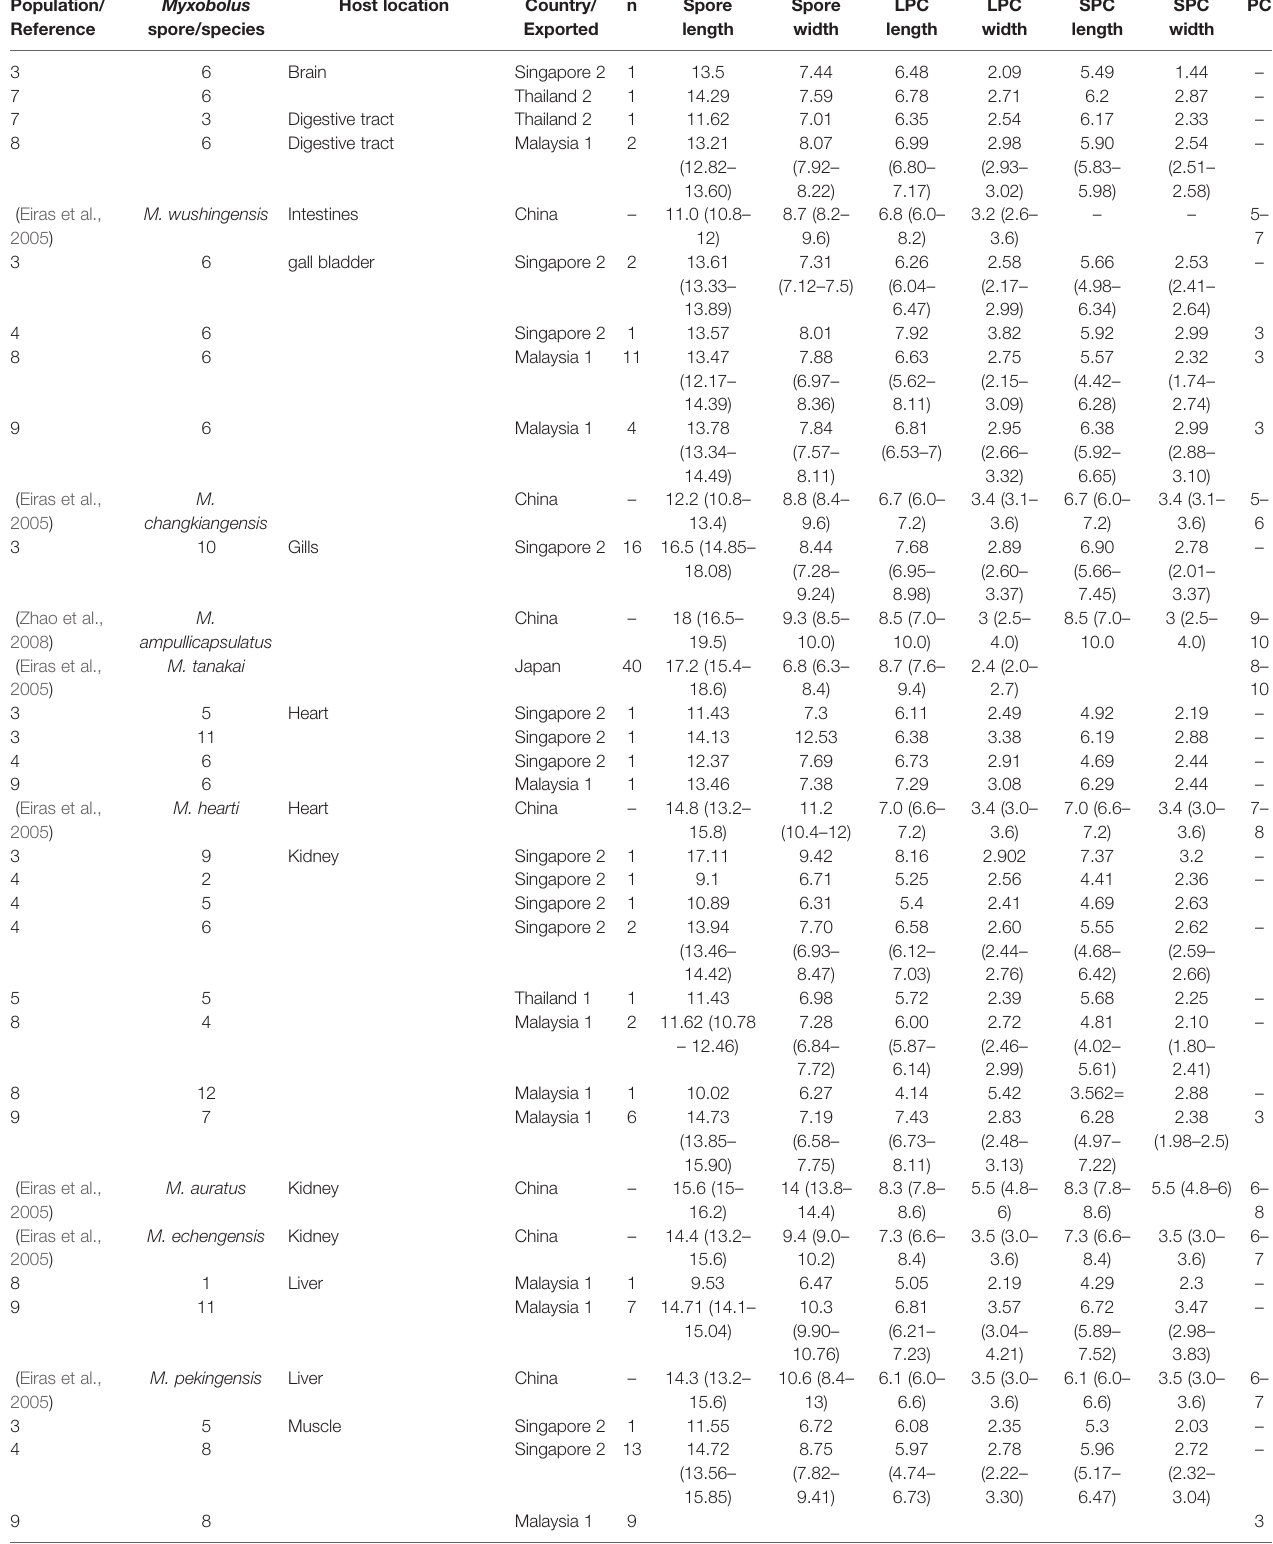
TABLE 3 | Morphometric comparison of Myxobolus spores found infecting imported Carassius auratus populations and similar Myxobolus species. Population/